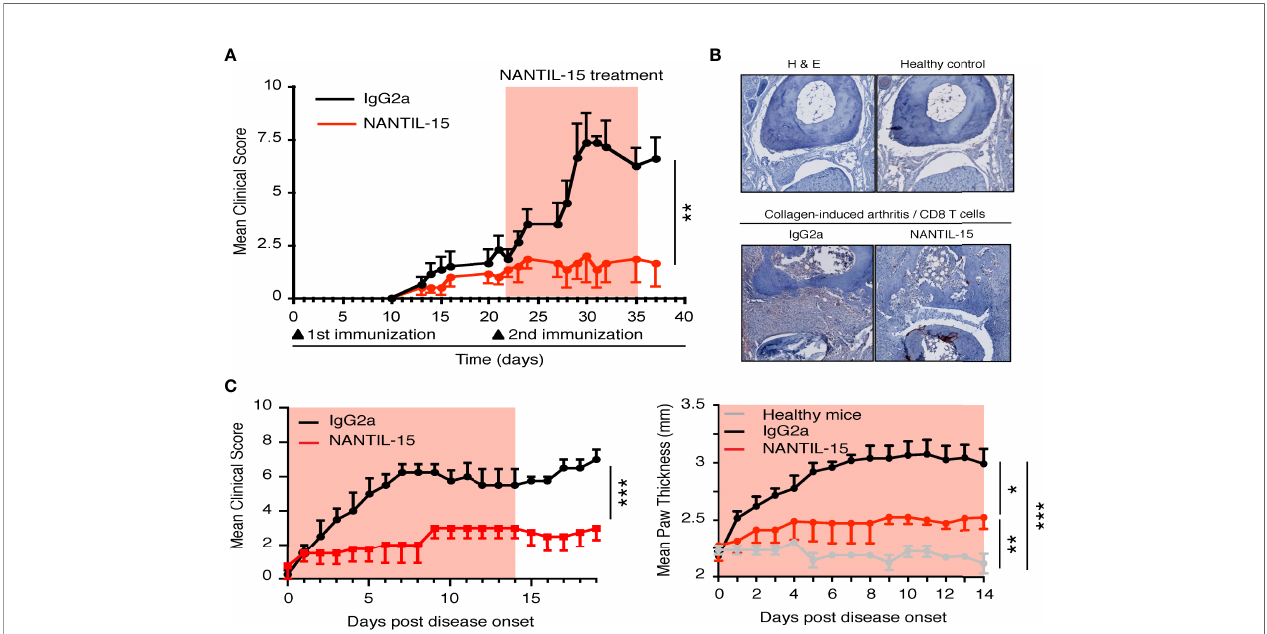
FIGURE 5 | NANTIL-15 reduces local in fl ammation in a collagen-arthritis mouse model. (A) NANTIL-15 reduces the signs of in fl ammation in a collagen-induced arthritis mouse model. Mice were immunized with collagen and challenged 21 days later with a second injection of collagen. One group of mice was treated 1 day following the second immunization with NANTIL-15 (5 m g/mouse/day), the other by the negative control IgG2a for 14 days. The clinical score was monitored for the duration of the experimental period (the light red squares indicate the period of treatment with NANTIL-15). Means clinical score ± SEM are given. (B) NANTIL-15 treatment reduces articular in fl ammation and joint destruction. Histological examination of ankle joints. After development of the fi rst symptoms of arthritis, joints from NANTIL-15- and IgG2a-treated animals (n = 6) were removed, formalin- fi xed, and decalci fi ed, and H&E stains were prepared. Representative sections of ankles from paws with a disease score of 2 on day 7 after disease onset are shown (magni fi cation 40×). Whereas IgG2a-treated animals show severe joint cartilage erosion and joint space narrowing (left panel), joints from NANTIL-15-treated animals show a relative normal morphology (right panel). (C) In a second collagen-induced arthritis mouse model experimental design, mice were immunized with collagen and challenged 21 days later with a second injection of collagen. Mice were synchronized when the fi rst symptoms of the disease appeared and divided into two groups. One group was treated with NANTIL-15 (1.5 m g/mouse/day), the other by the negative control IgG2a for 14 days. The clinical score (left panel; Mann – Whitney test, ***IgG2a vs. NANTIL-15) and paw thickness (right panel; Kruskal – Wallis test with Dunn ’ s post-test, *IgG2a vs. NANTIL-15, ***IgG2a vs. healthy, **NANTIL-15 vs. healthy) were monitored during treatment and for a period of 2 weeks (the light red squares indicate the period of treatment with NANTIL-15). Means clinical score and paw thickness ± SEM are